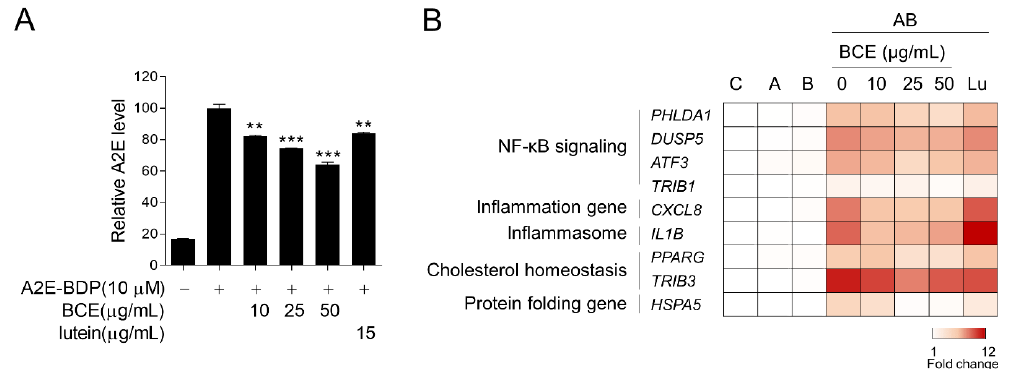
Figure 3. Inhibition of A2E accumulation by BCE in ARPE-19 cells. ( A ) ARPE-19 cells pretreated with BCE (10–50 µ g/mL) or lutein (15 µ g/mL) were treated with A2E-BDP (10 µ M) for 24 h. The relative A2E level was quantified by measuring their fluorescence at 485 nm (excitation) and 535 nm (emission) using a fluorescence microplate reader. The results are presented as the mean ± standard deviation of two independent experiments ( n = 2). ** p < 0.01, *** p < 0.001 vs. A2E-BDP. ( B ) Heatmap generated from RT-qPCR results performed on the in vitro RPE damage model. After 24 h of BL exposure, the total RNA was isolated using TRIzol reagent. cDNA synthesized from mRNA was used for RT-qPCR. The mRNA levels were normalized to 18S rRNA levels. Values represent the log2 fold-change relative to CTR. C, control; A, A2E; B, blue light; AB, A2E + BL. ATF3 , activating transcription factor 3; CXCL8 , C-X-C motif chemokine ligand 8; DUSP5 , dual specificity phosphatase 5; HSPA5 , heat shock protein family A (Hsp70) member 5; IL1B , interleukin 1 beta; PHLDA1 , pleckstrin homology like domain family A member 1; PPARG , peroxisome proliferator activated receptor gamma; TRIB1 , tribbles pseudokinase 1; TRIB3 , tribbles pseudokinase